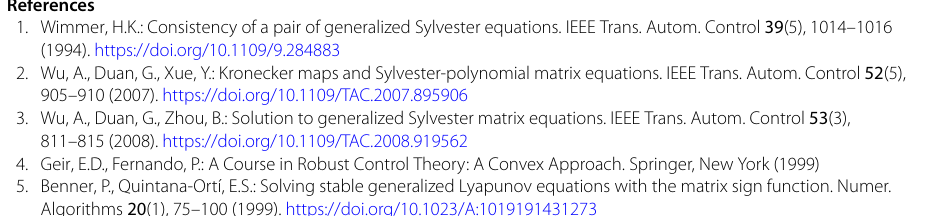
(cid:2) p ⊗ A B T condition number of t . As applications, our algorithm can be adapted to the t =1 t discretization of the one-dimensional heat equation and the two-dimensional Poisson’s equation. According to numerical simulations, our algorithms converge fast to the exact solution in spite of a little more computational time compared to other methods. The nu- merical examples for heat and Poisson’s equations in Sects. 6 and 7 guarantee the capability and adaptability of our proposed